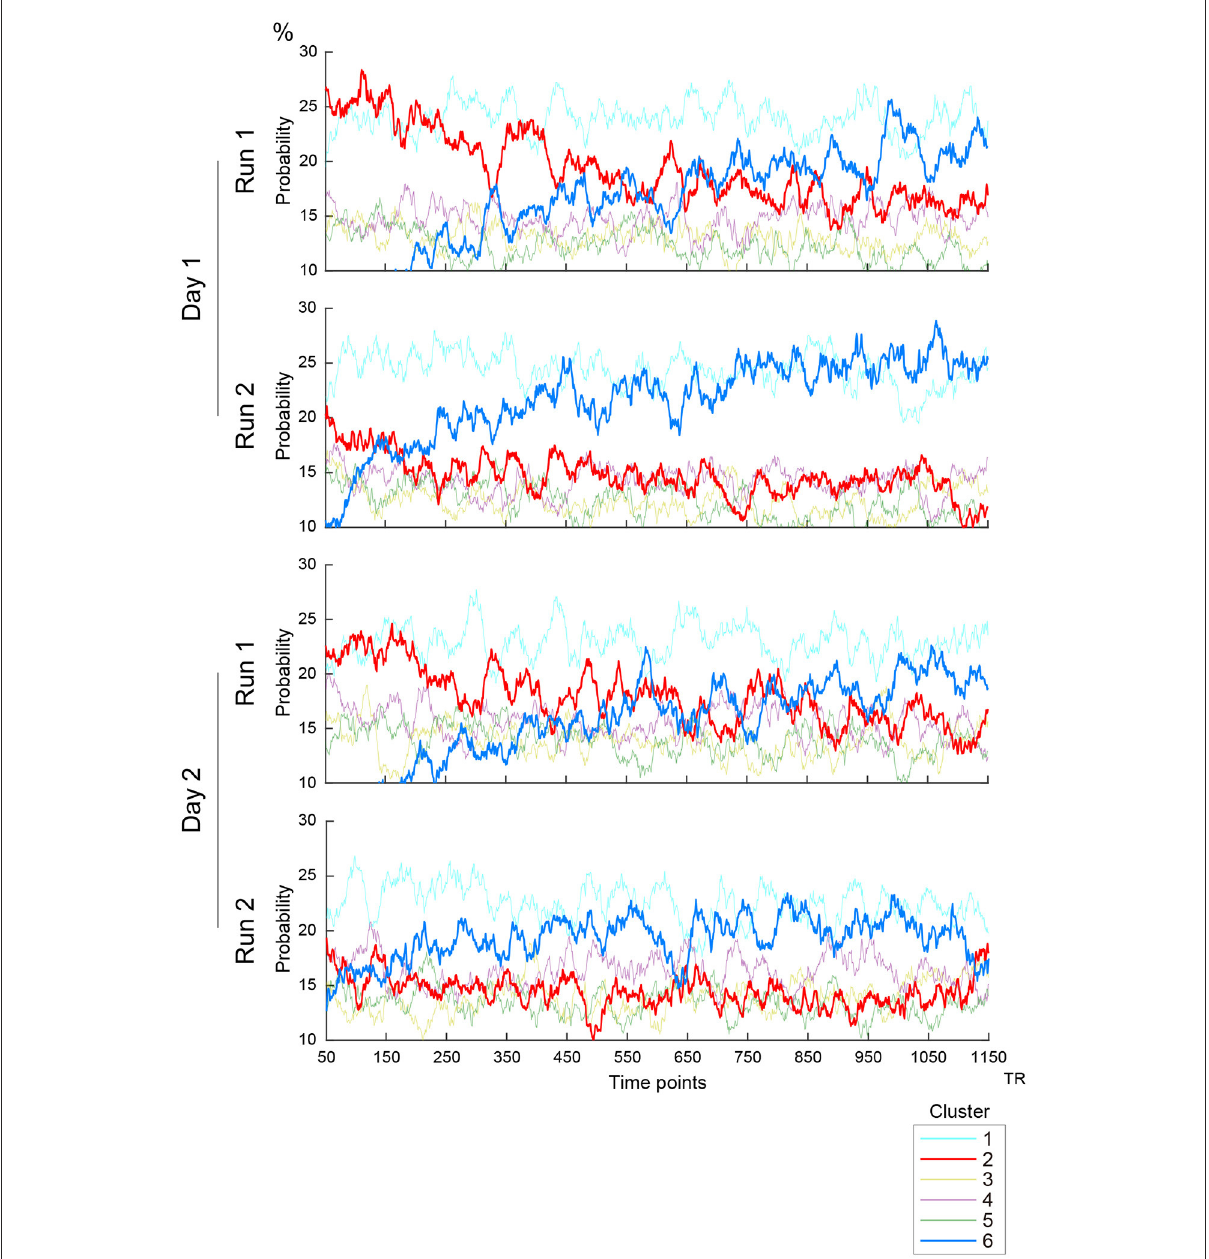
FIGURE3 Timecourses of the occurrence of clusters. Vertical and horizontal lines indicate occurrence probability and time, respectively. Line colors indicate clusters as labeled in the right inset. Four scanning runs were administered in two days, and the panels show the timecourses of the first and second scanning runs on Days 1 and